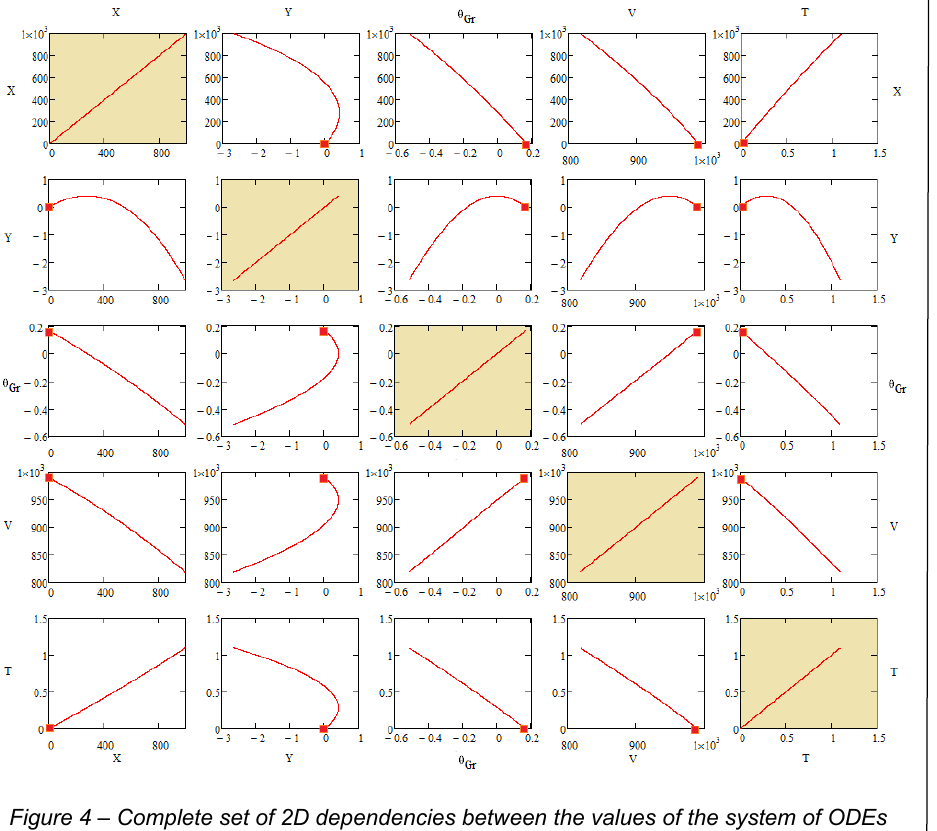
Figure 4 – Complete set of 2D dependencies between the values of the system of ODEs (1) Рис . 4 – Полное множество 2D зависимостей между величинами системы ОДУ (1) Слика 4 – Комплет 2D зависности између вредности система ОДЈ